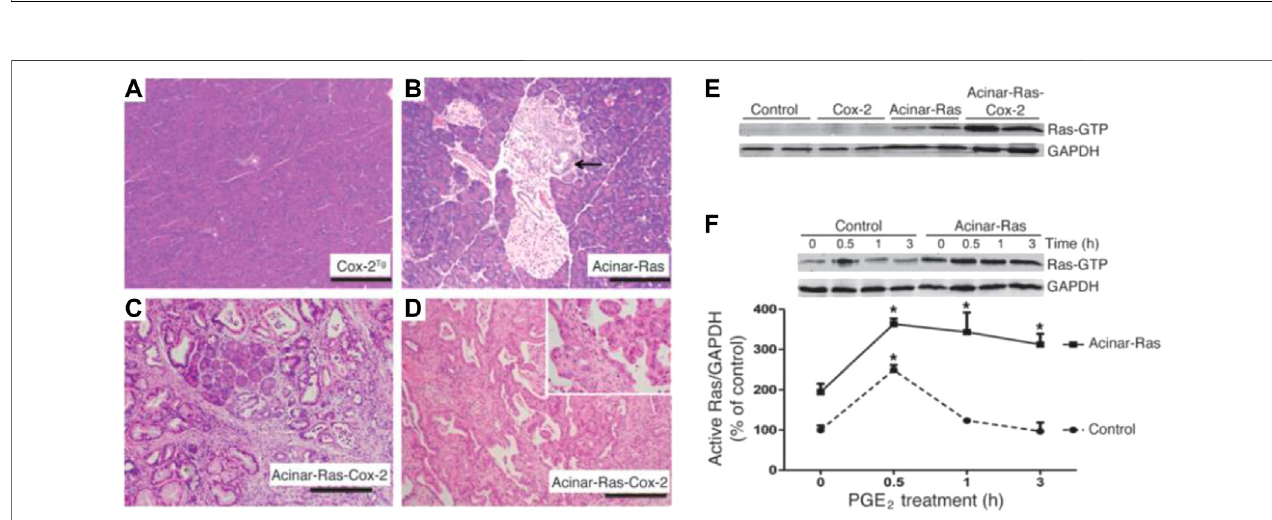
FIGURE 6| COX-2 and oncogenic K-Ras synergized to promote the development ofchronic in fl ammation and cancer. Reproduced from Daniluk et al., 2012 with permission from JCI. Copyright 2012.